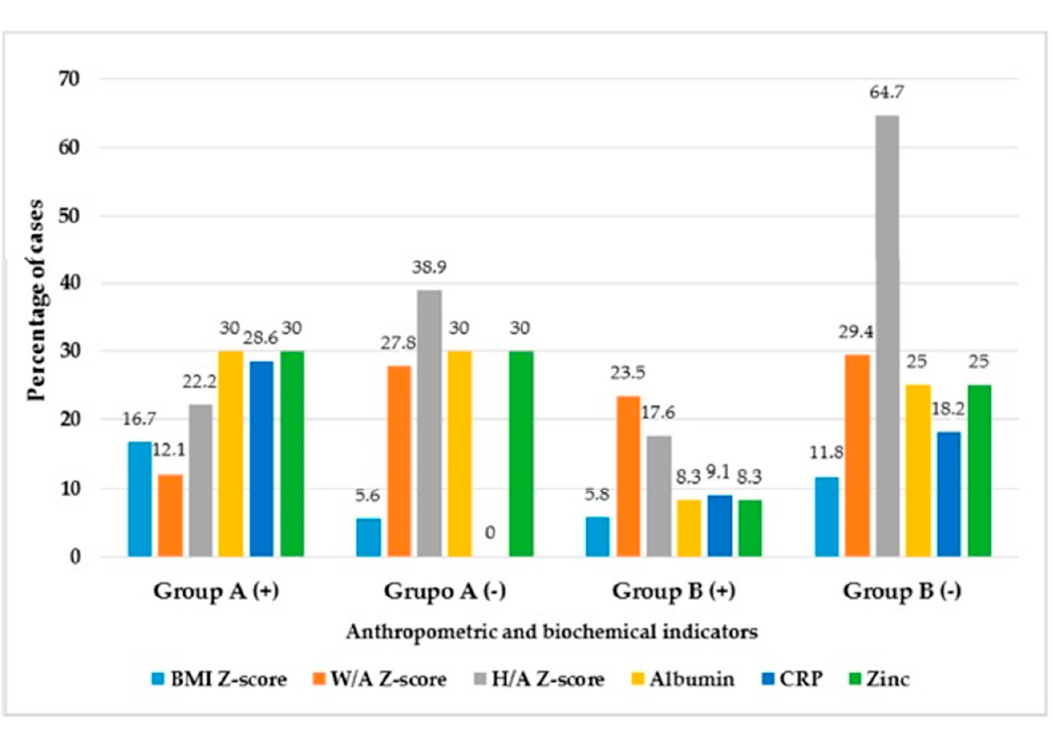
Figure 4. Percentage of cases with positive ( + ) or negative ( − ) change by groups of zinc supplementation. BMI: body mass index, W / A: weight-for-age, H / A: height-for-age, CRP: C-reactive protein, Albumin; serum albumin level, Zinc: serum zinc